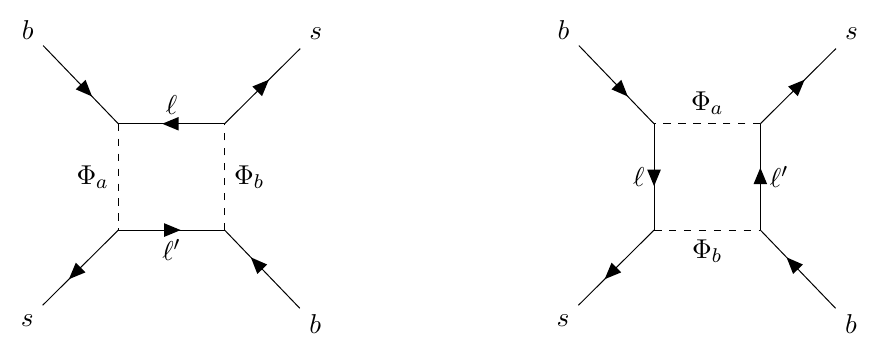
Figure 1 . Feynman diagrams depicting leading-order scalar LQ contributions to the Wilson coefficients C (0) i